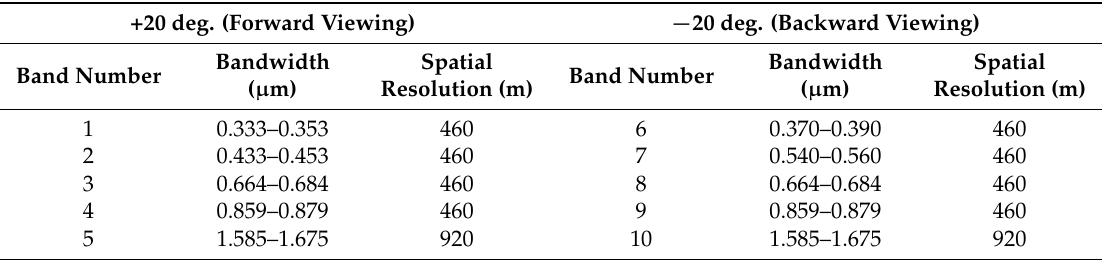
Table 5. Specification of GOSAT TANSO-CAI-2. +20 deg. (Forward